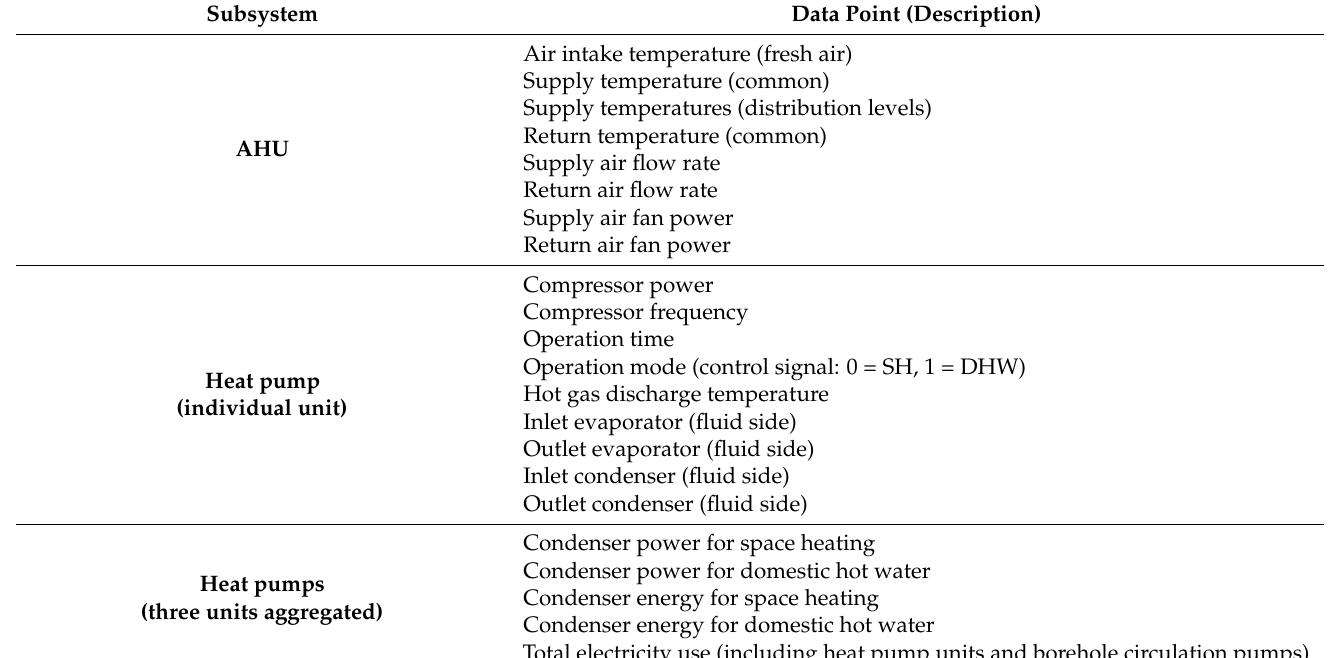
Table 2. Main data points used for the data analysis presented in this